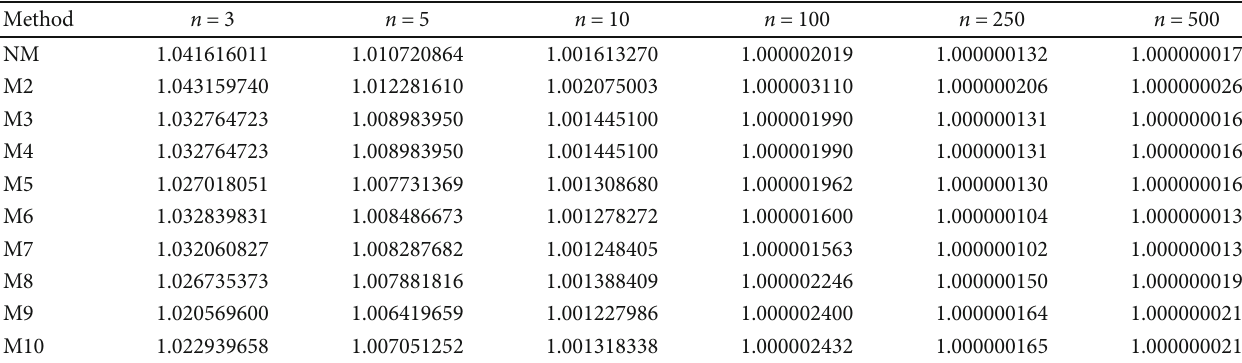
fi rst category to solve Test Problem 1, and n = 3, 5, 10,100,250,500 . Table 22: The values of I op for the methods in the Method